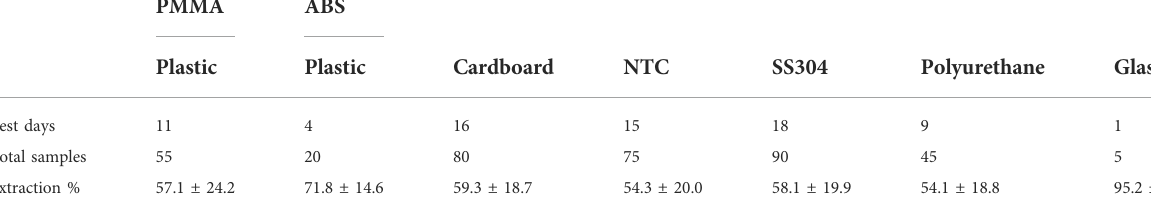
TABLE 1 Average extraction ef fi ciency of Φ 6 virus 4 – 14 days after drying on different